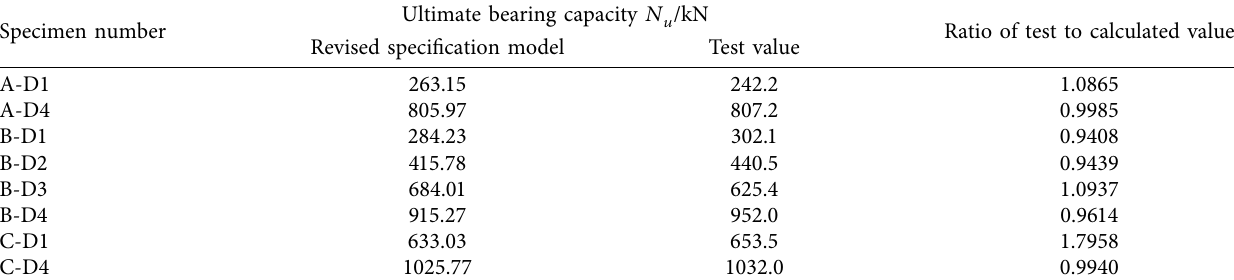
Table 7: Comparison of the calculated value and test value of load-bearing capacity of the revised standard